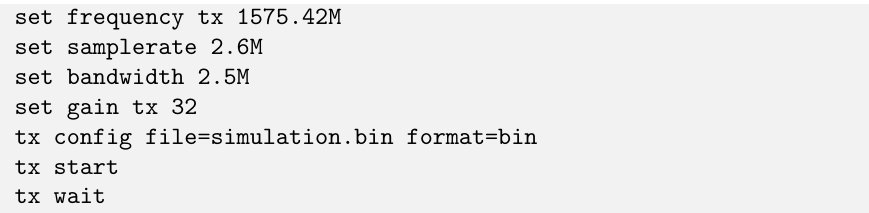
Figure 7. Script used to spoof the GNSS